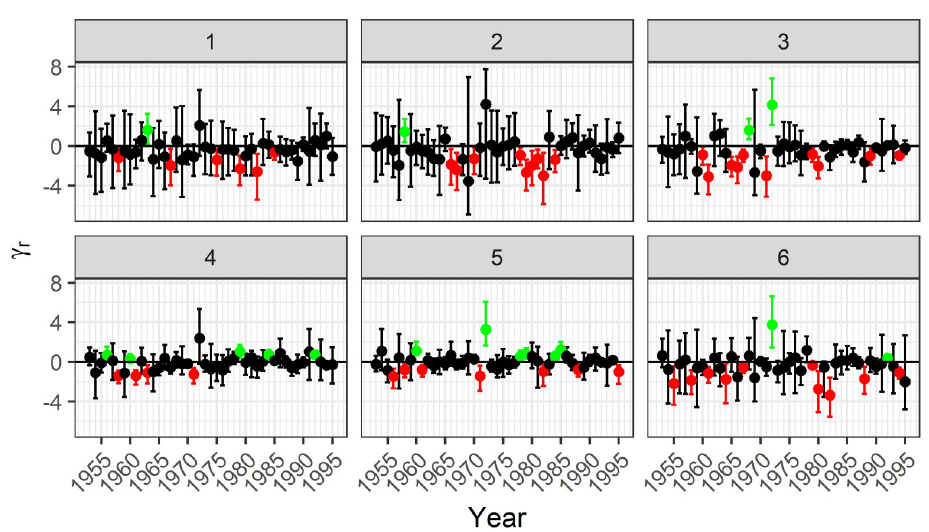
Fig 3. Posterior median estimates and 90% credible intervals for the linking parameter in the model for lightning- caused fires. There are very few years where the credible interval was entirely above 0, but several where it was below. This indicates that the size and count of lightning-caused fires often a negative association. Days with fewer fires had larger fires, and days with more fires had smaller fires.